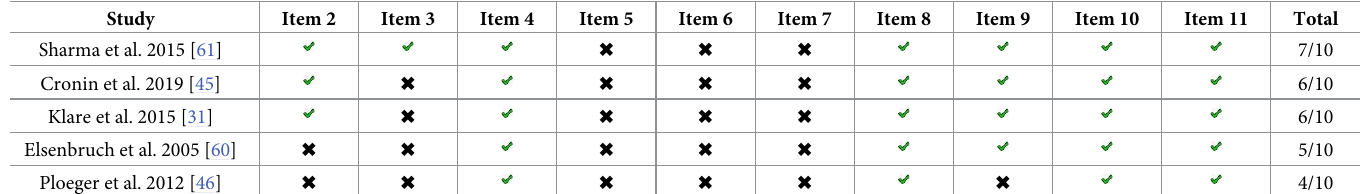
Table 3. Risk of bias.